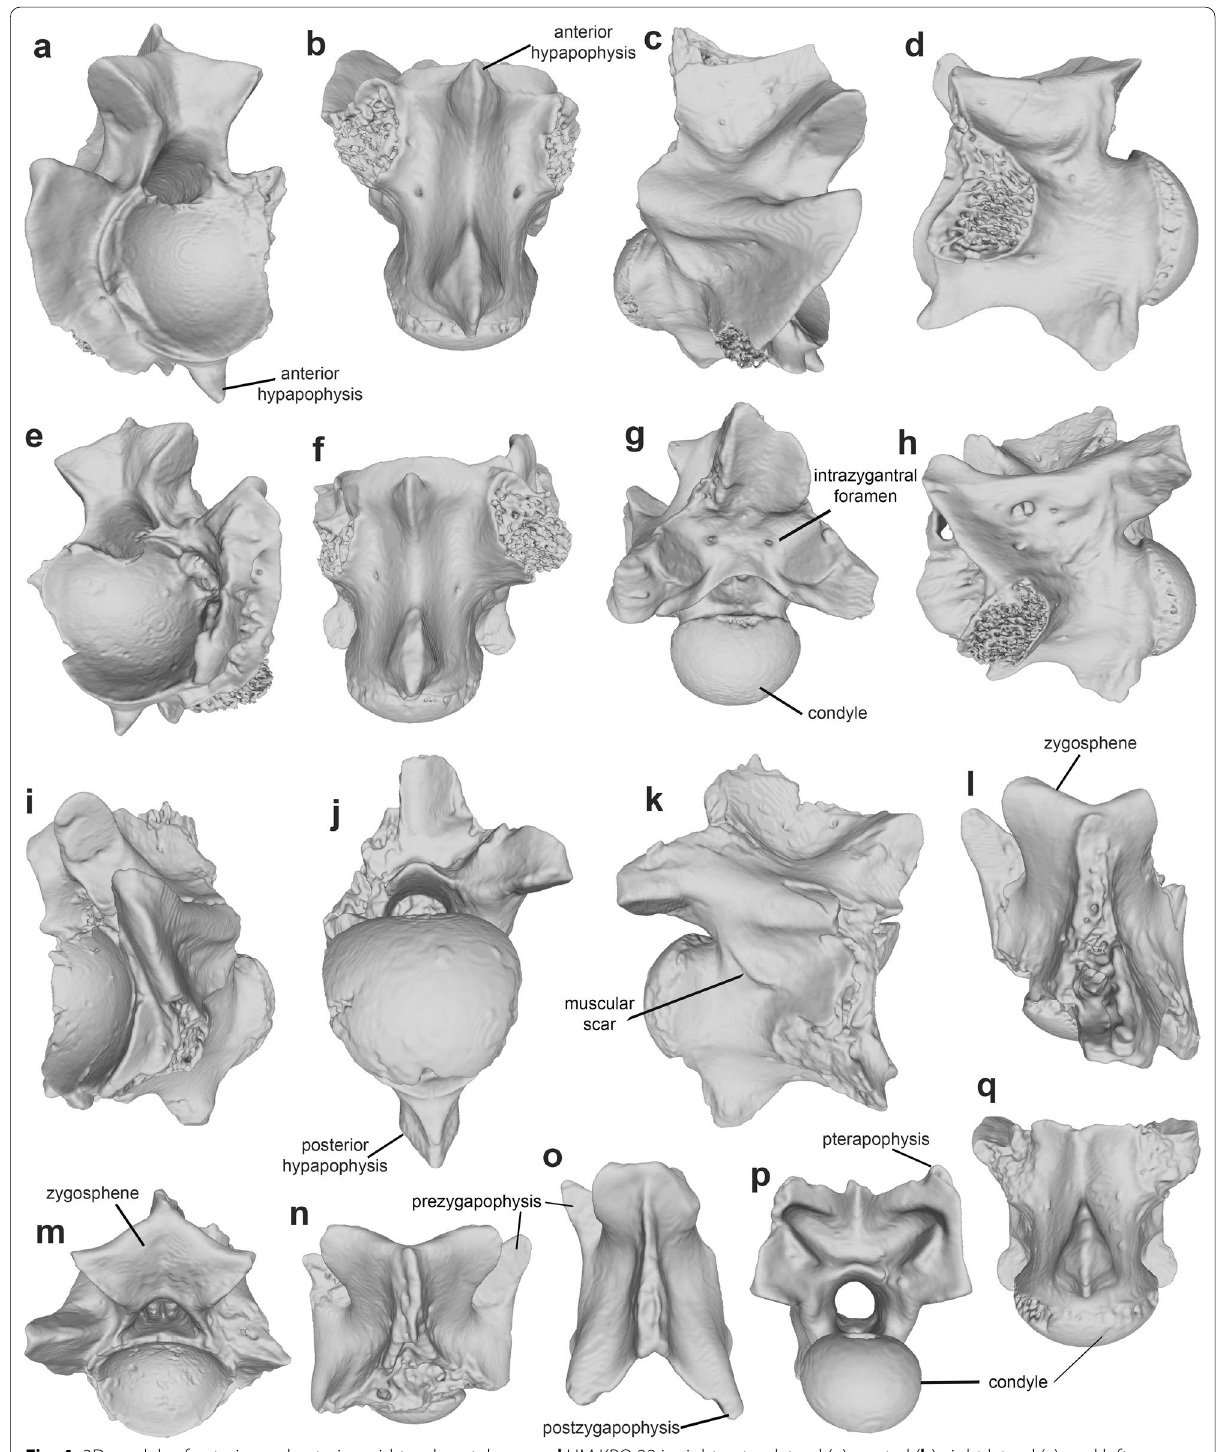
Fig. 4 3D models of anterior and anterior mid-trunk vertebrae: a–d UM KPO 22 in right anterolateral ( a ), ventral ( b ), right lateral ( c ), and left ventrolateral ( d ) views; e–h UM KPO 33 in left anterolateral ( e ), ventral ( f ), posterodorsal ( g ), and left lateral ( h ) views; ( i–l ) UM KPO 25 in left anterolateral ( i ), posterior ( j ), right lateral ( k ), and dorsal ( l ) views; m–n UM KPO 32 in anterodorsal ( m ) and dorsal ( n ) views; ( o–p ) UM KPO 34 in dorsal ( o ) and posterior ( p ) views; ( q ) UM KPO 37 in ventral view. Specimens not to the same